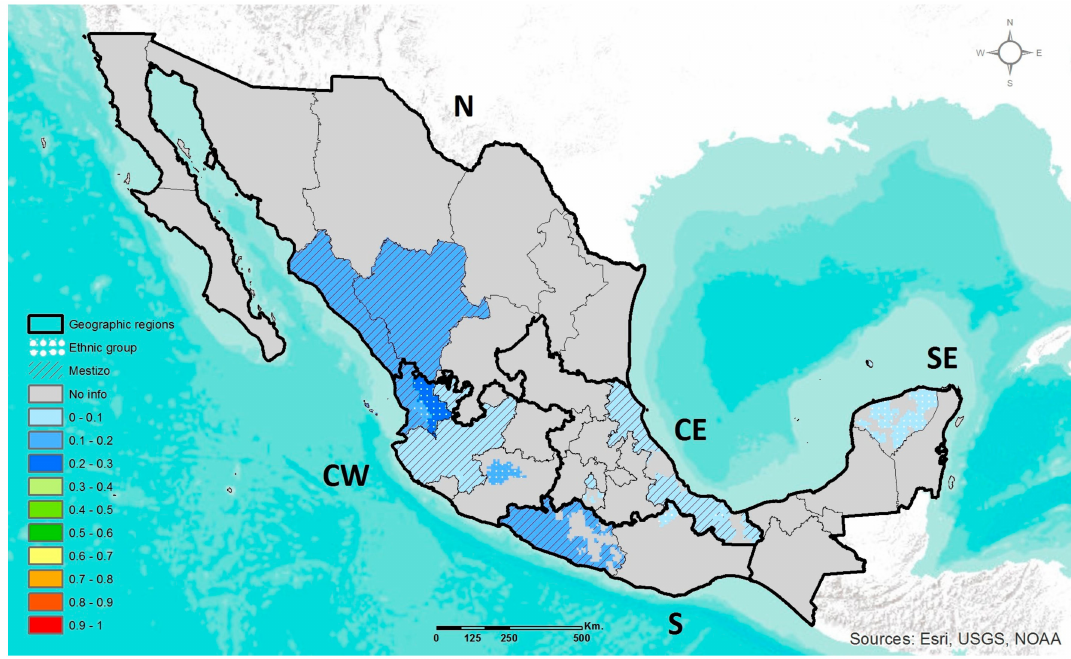
Figure 3. Geographic distribution of APOE ε 4 allele in ethnic groups and Mestizo population of